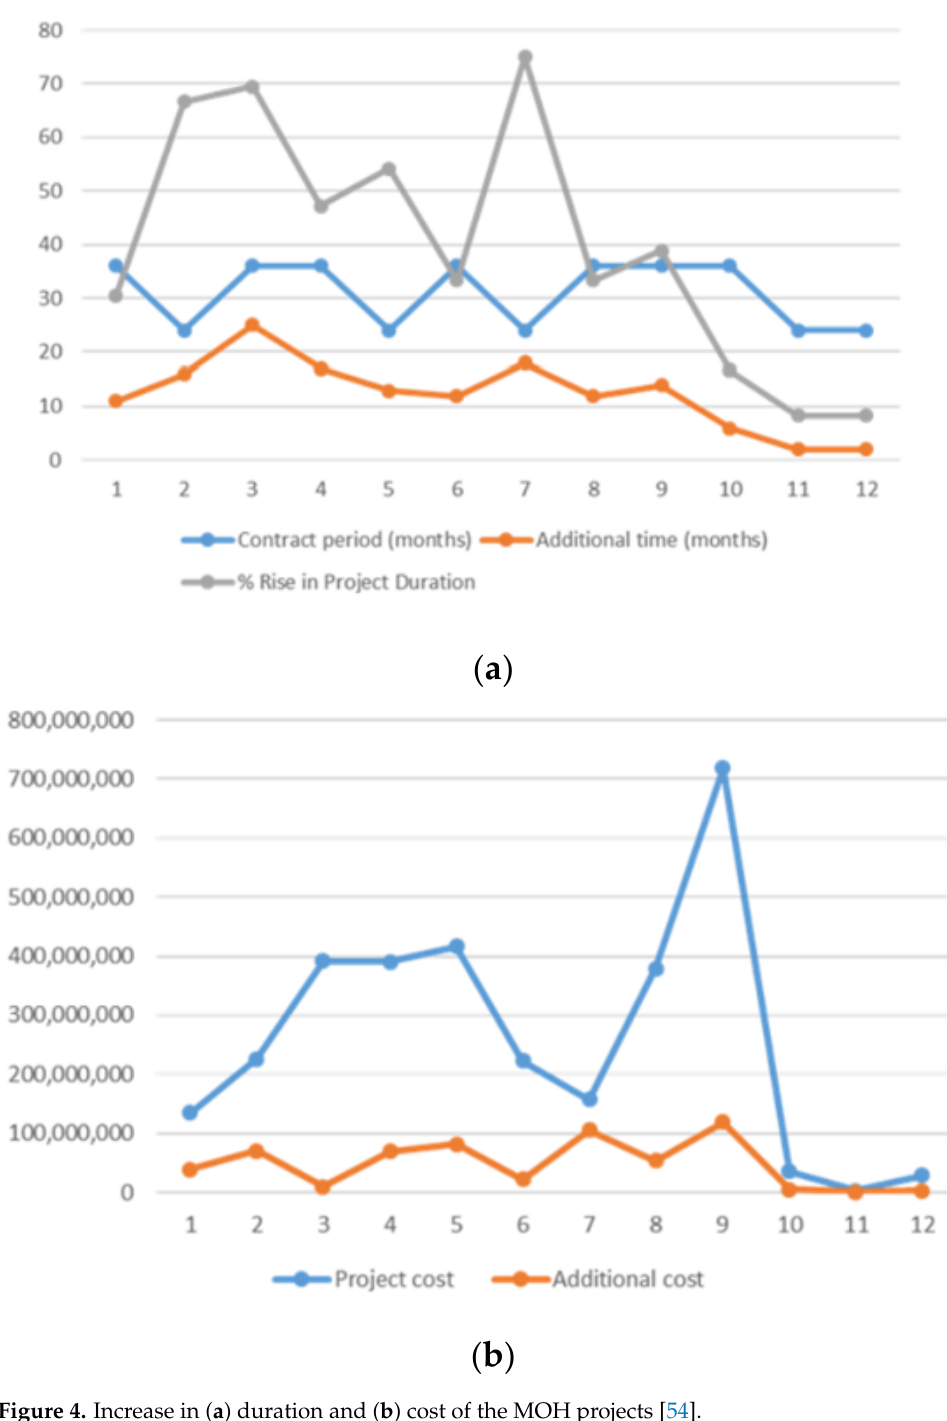
Figure 4. Increase in ( a ) duration and ( b ) cost of the MOH projects [54].